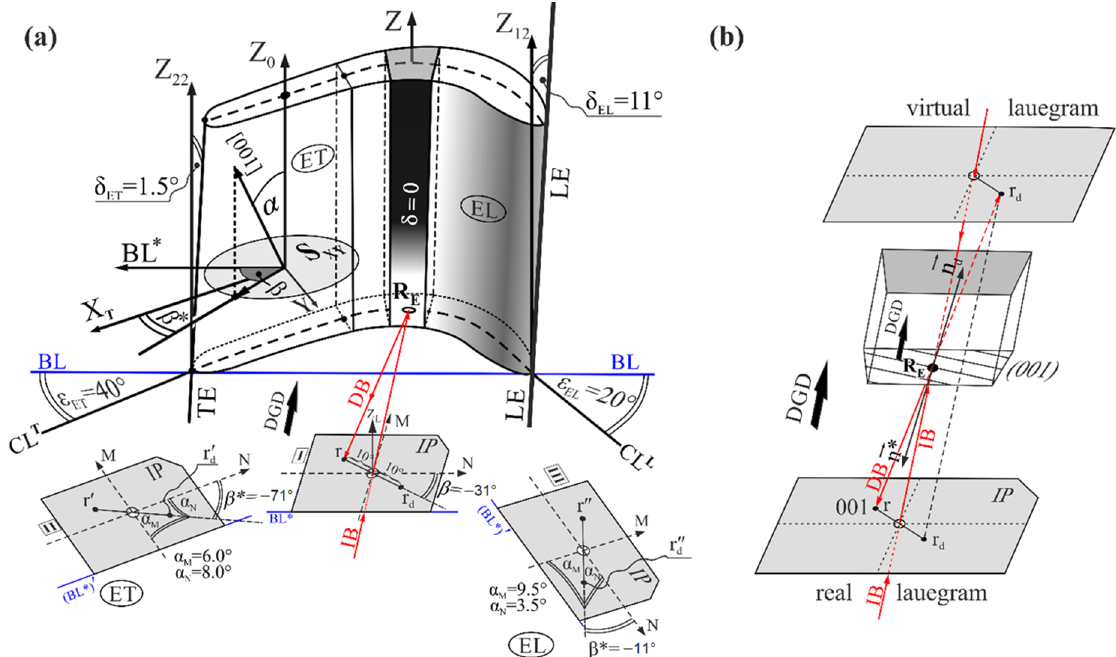
Figure 5. Exemplary illustration of the areas EL and ET of the upper sample of an airfoil obtained at the withdrawal rate of 5 mm/min, with geometric description of angles α , β and β * ( a ) and a diagram explaining how to determine the position of the spot r d on the lauegram through inversion of the spot r ( b ). The plane S XY is parallel to the plane p and cross-sections I, II and III in Figure 1a, while the BL* of the lauegram is parallel to the BL of an airfoil cross-section. IP—image plate, IB and DB—incident and diffracted X-ray beam, DGD—dendrite growth direction. n ∗ and n d —unit vectors which proceed in a normal direction towards the diffraction plane (001) with the direction corresponding to the diffracted beam and the dendrite growth direction. Z 0 , Z 12 and Z 22 are parallel to the Z axis of the blade.